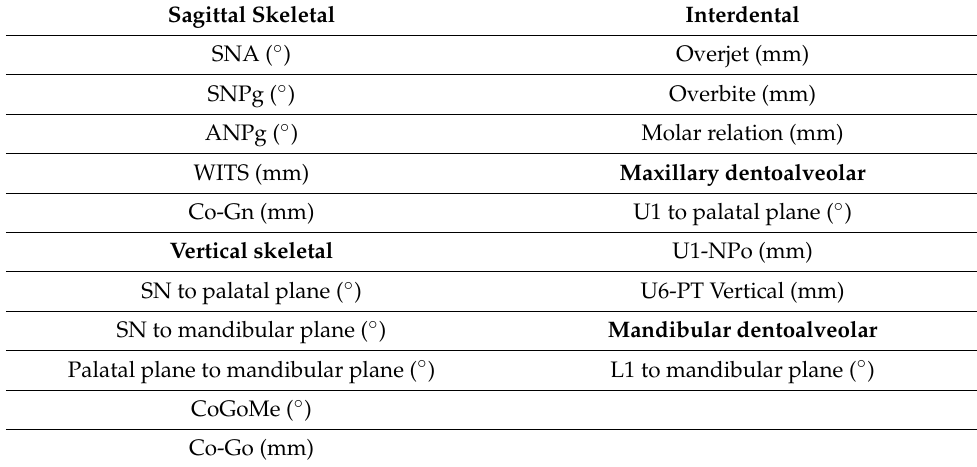
Table 1. Analyzed cephalometric